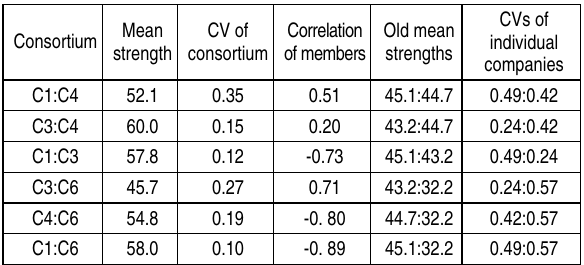
Table 44. Summary of consortia